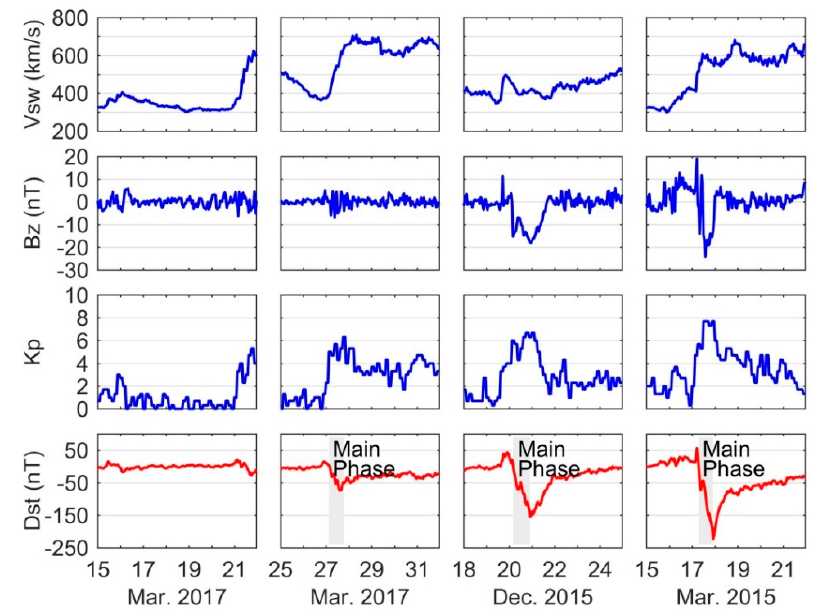
Figure 3. The variations of solar wind speed Vsw, IMF B Z , Kp index and geomagnetic index Dst during the quiet, moderate, intense, and super storm periods.